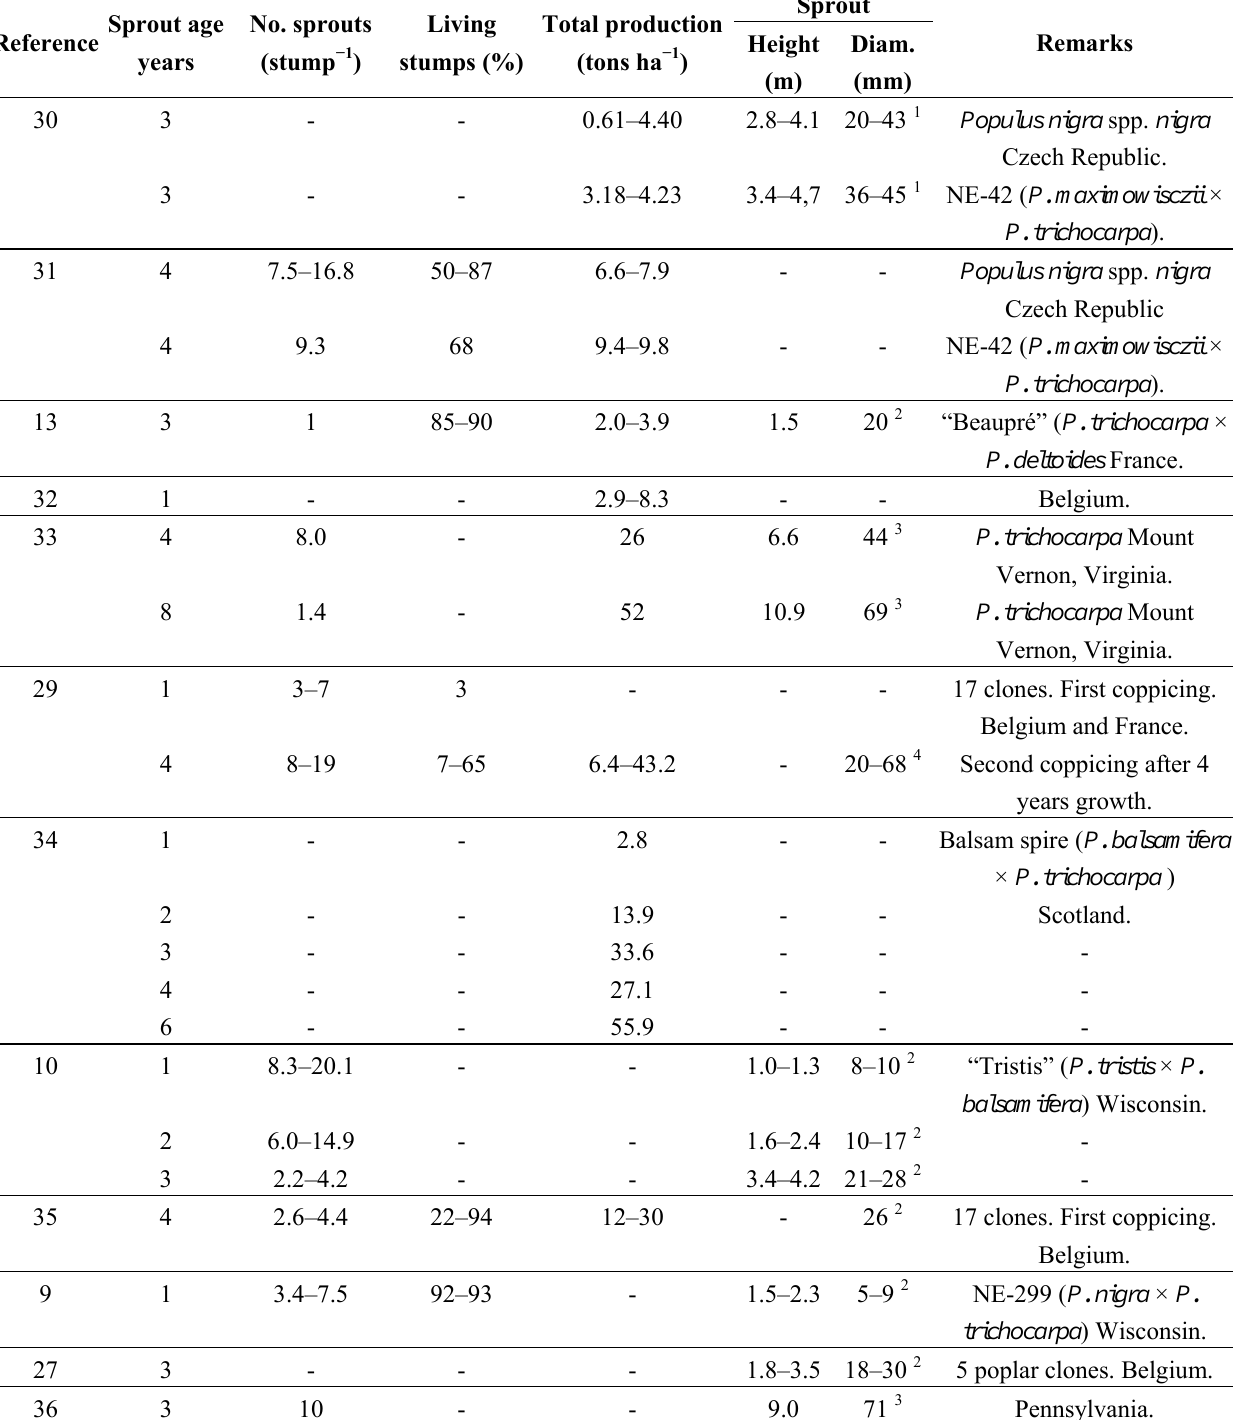
Table 8. Reported sprout characteristics for poplar ( Populus